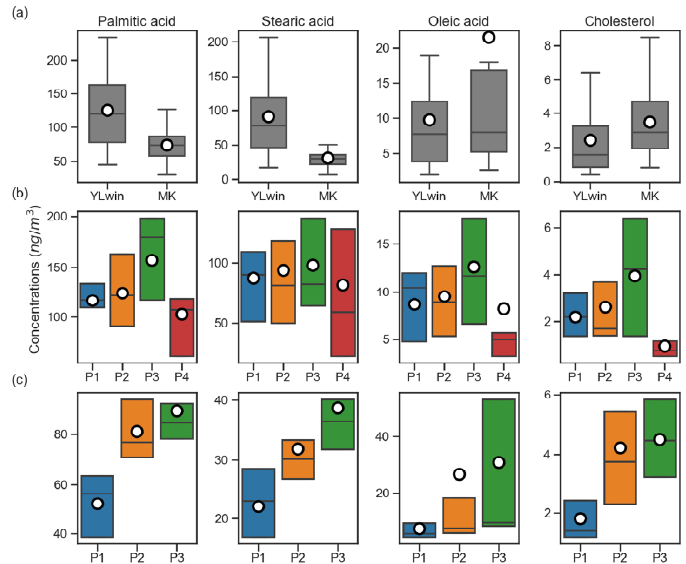
Figure 6. ( a ) Abundance of fatty acids and cholesterol in ng/m 3 at Yuen Long (YL) and Mong Kok (MK) sites. ( b ) YL site: diurnal variations of fatty acids and cholesterol as seen through the time-segments of P1 to P4, namely 06:00–11:00 (P1), 11:00–16:00 (P2), 16:00–21:00 (P3) and 21:00–06:00 (P4). ( c ) MK site: diurnal variations of the same set of organic tracers as seen through the time-segments of P1 to P3 (no sampling during P4 at this site). The lower bound of the box denote the 25th percentile and the upper bound denote the 75th percentile. The solid lines represent the medians and the white dots with black edge represent the averages.